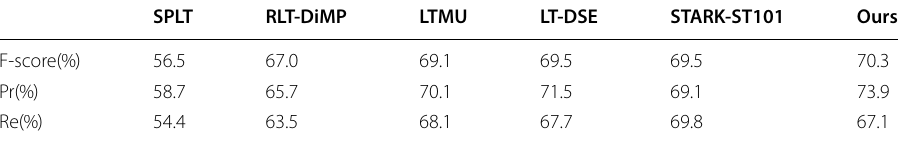
Table 3 Comparisons on VOT-LT2021 benchmark. The best results are marked in the red font